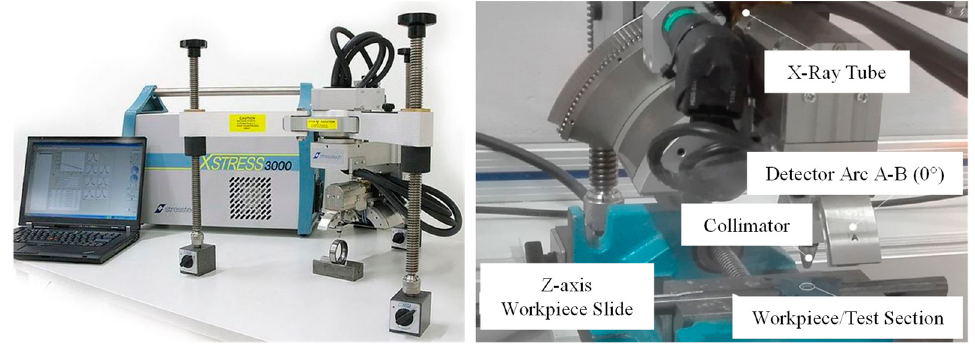
mA. For each wire-drawing variant and the initial state, three workpieces were measured tial directions. The surface of the wires was etched to a depth of 40 µm at the measuring point, which was in the middle of the drawn specimen length. Figure 3 illustrates the measurement setup.